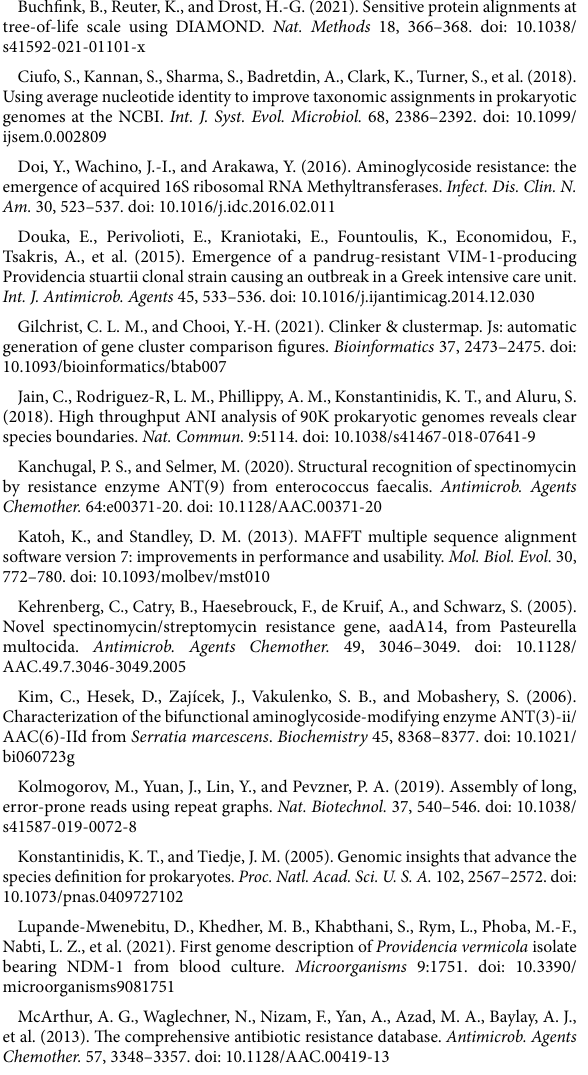
SUPPLEMENTARY FIGURE S1 SDS-PAGE of AadA33. Lane 1: PageRuler Prestained Protein adder (Thermo Fisher Scientific, product code: 26616); lane 2 and 3: uncleaved AadA33 with His6 tag; lane 4: cleaved AadA33 with